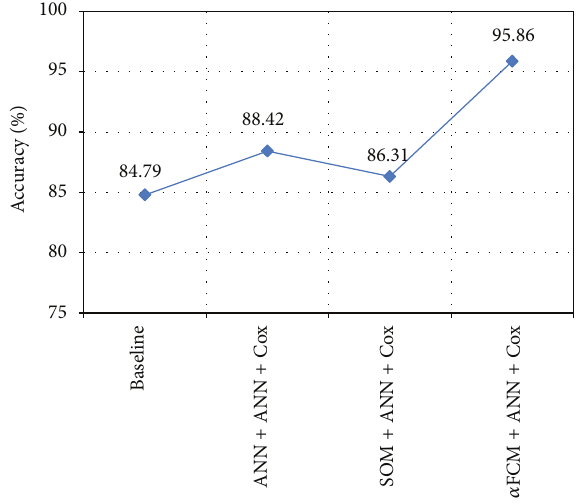
Figure 3: The accuracy of hierarchical models.